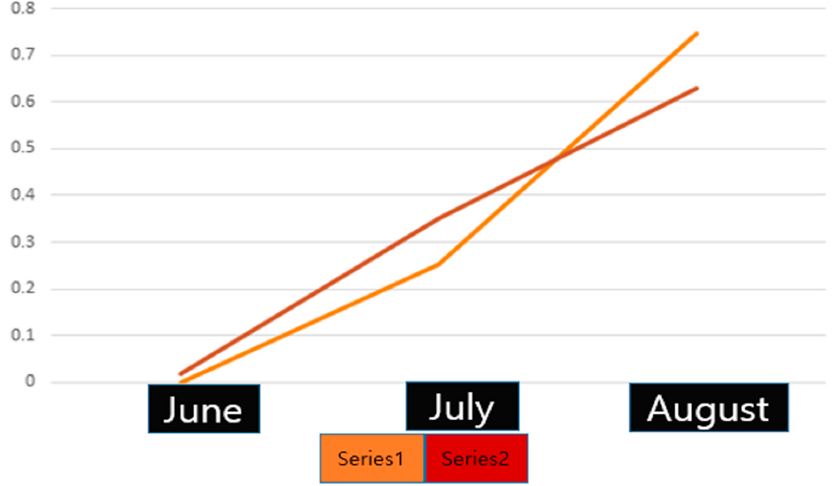
Figure 28. The frequency of appearance for the word “tropical night” and the changes in photovoltaic power generation in June, July, and August 2016.